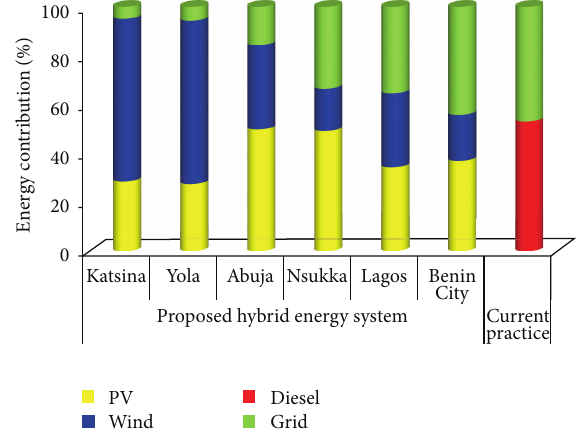
Figure 8: Comparison of electrical characteristics between the proposed system and the current traditional